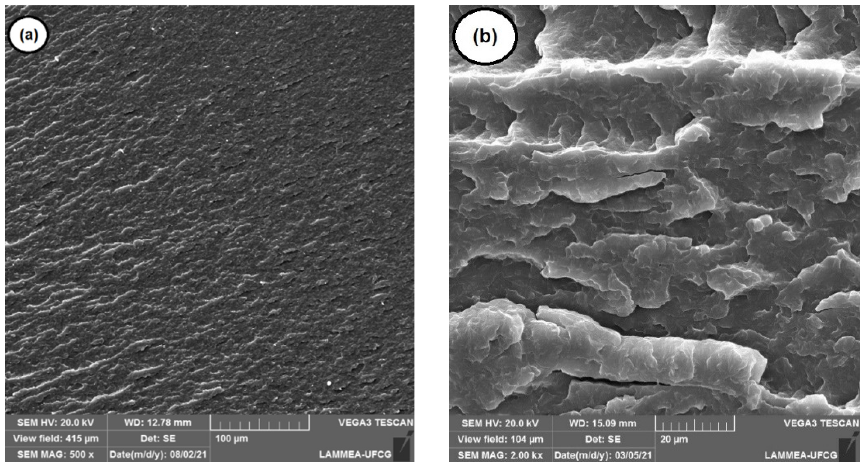
Figure 6. SEM micrographs showing the morphology on the fracture surface of pure PA6: ( a ) 500× magnification; ( b ) 2000× magnification.